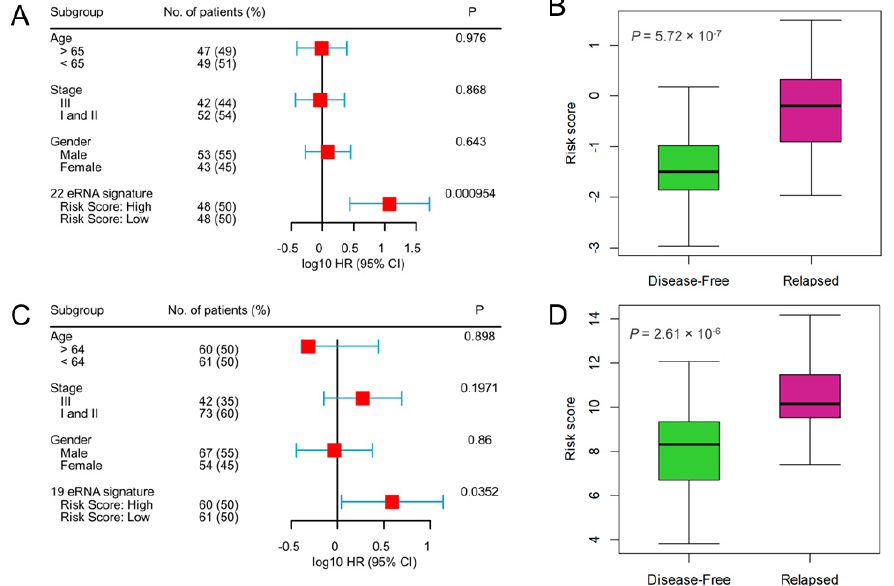
Figure 4. Multivariate Cox-regression analysis shows survival prediction by enhancer RNA signature is independent of clinical risk factors, and enhancer RNA signature risk score is up-regulated in